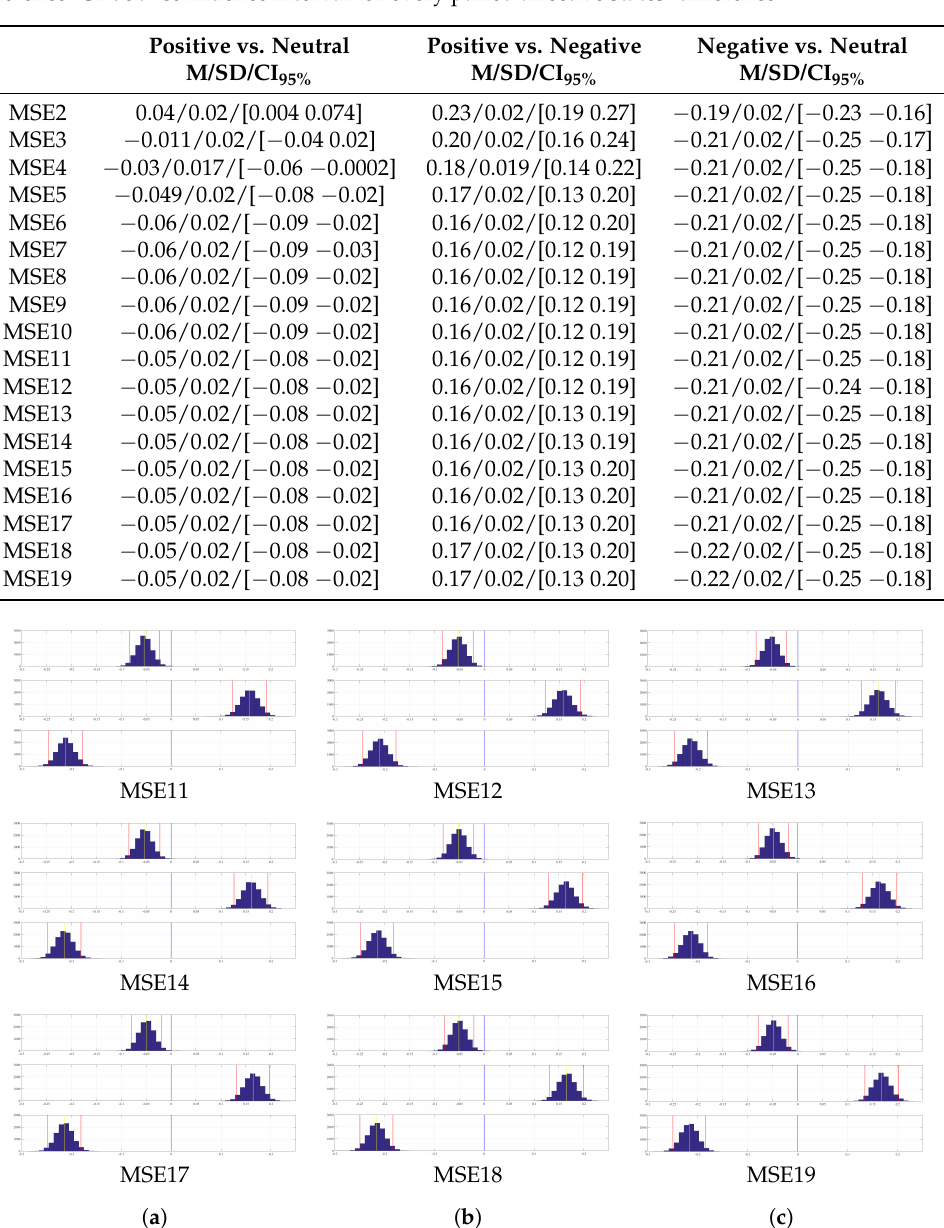
Table A10. Paired two-sample bootstrap test of significance (10,000 simulation runs) at 95.0% confidence interval (CI) applied on the participants’ MSE2s (i.e., 62 MSE2s associated with 62 EEG channels of a participant, per affect) through MSE19s (i.e., 62 MSE19s associated with 62 EEG channels of a participant, per affect) values. Compared pairs of mental states are: positive versus neutral, positive versus negative, and negative versus neutral. M: mean difference, SD: standard deviation of such a difference. CI: 95% confidence interval for every paired affective states’ difference. Positive vs. Neutral Positive vs. Negative